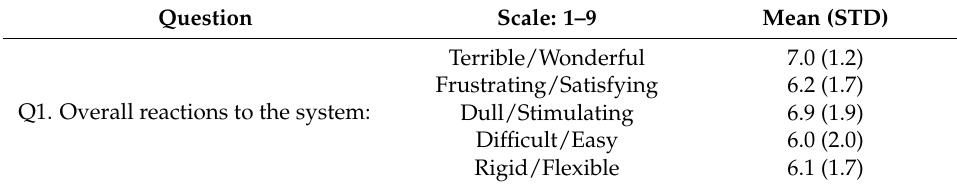
Table 4. Results of QUIS Part 1—Overall User Reactions.